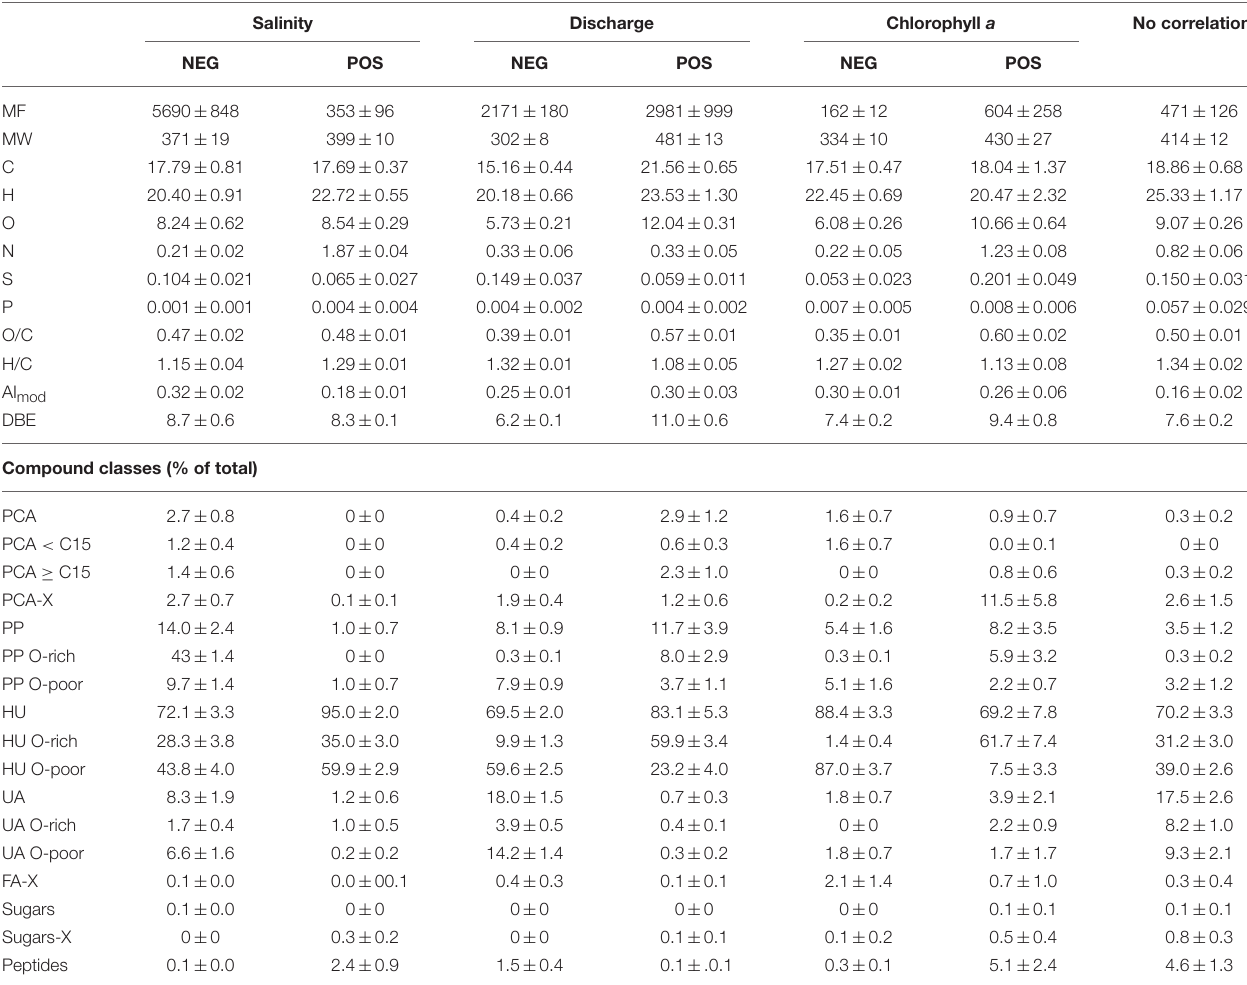
TABLE 1 | Characteristics of molecular formulae correlating positively (POS) or negatively (NEG) with salinity, discharge and chlorophyll a concentration as well as of those molecules exhibiting no correlation to either one of the three environmental parameters. Salinity Discharge Chlorophyll a No